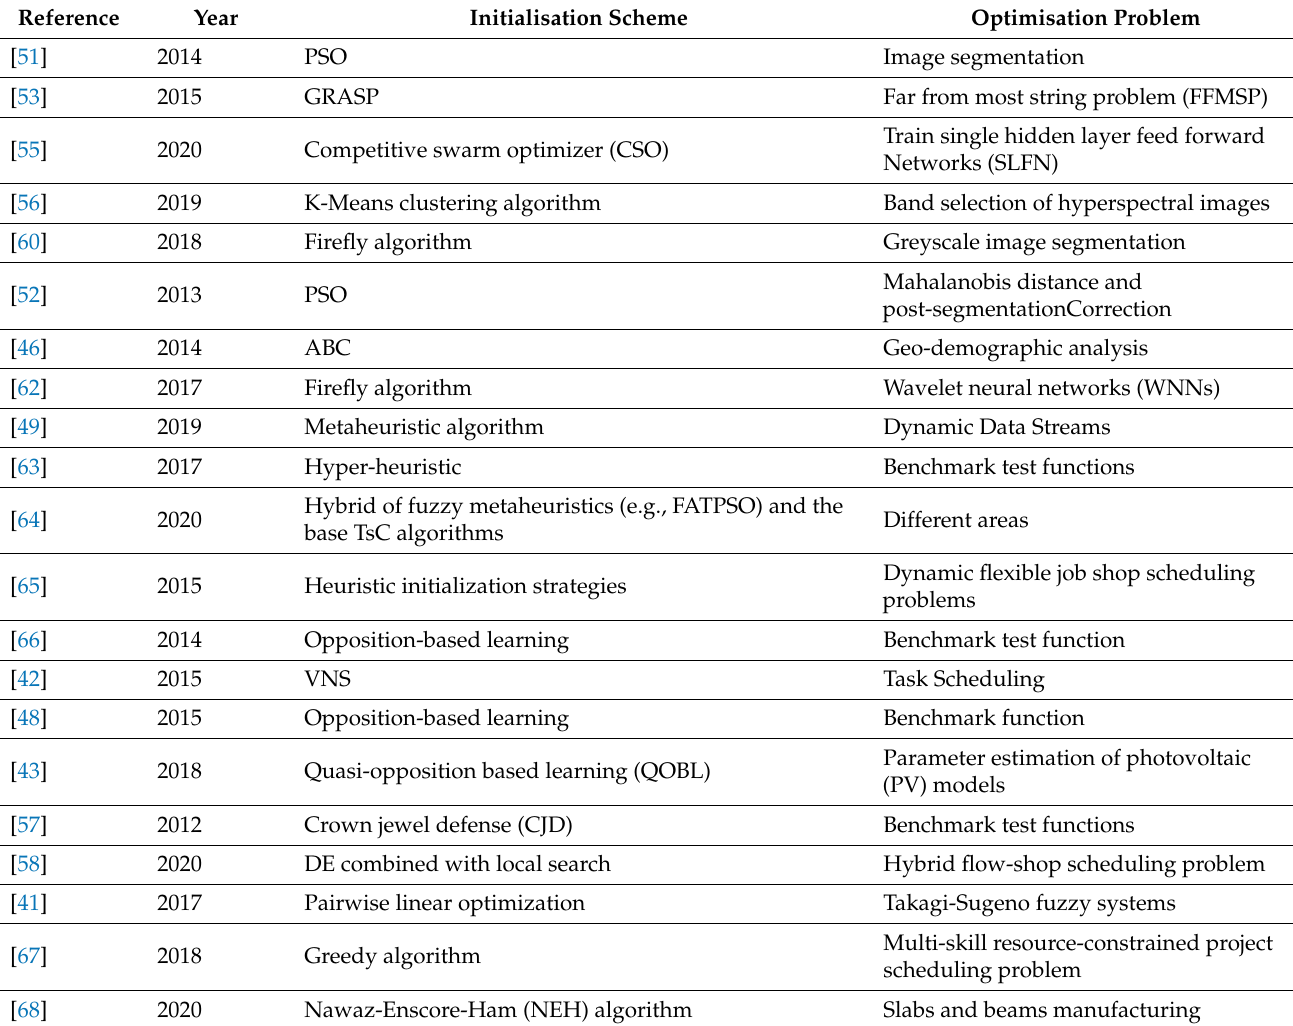
Table 4. Summary of hybrid